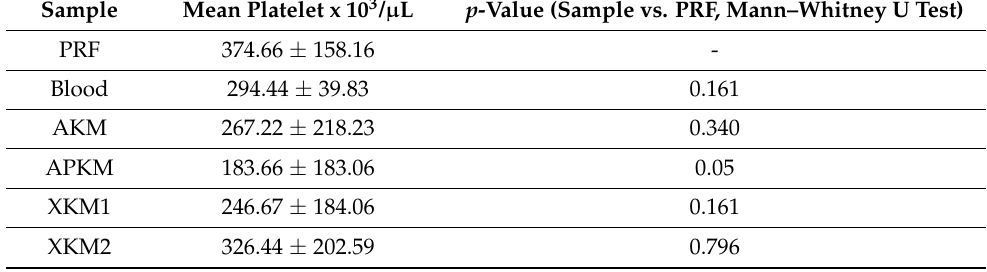
Table 1. Mean total platelet count x 10 3 / μ l with standard error after 15 min of incubation of each BSM with PRF in comparison to PRF alone and EDTA blood. p -values are given for the comparison of each sample with PRF alone (Mann–Whitney U-test).